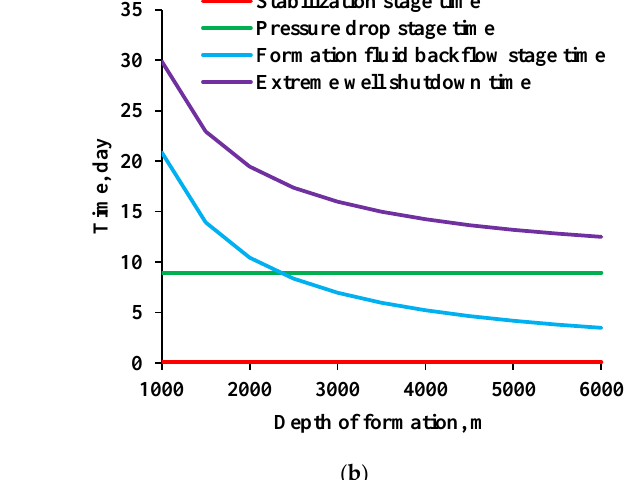
Figure 7. Influence of cumulative gas injection rate on the limit shut-in time of a waterproof com- pound. ( a ) Influence of accumulated gas volume on the limit shut-in time of a waterproof compound; ( b ) Influence of formation depth on the limit shut-in time of a waterproof compound.